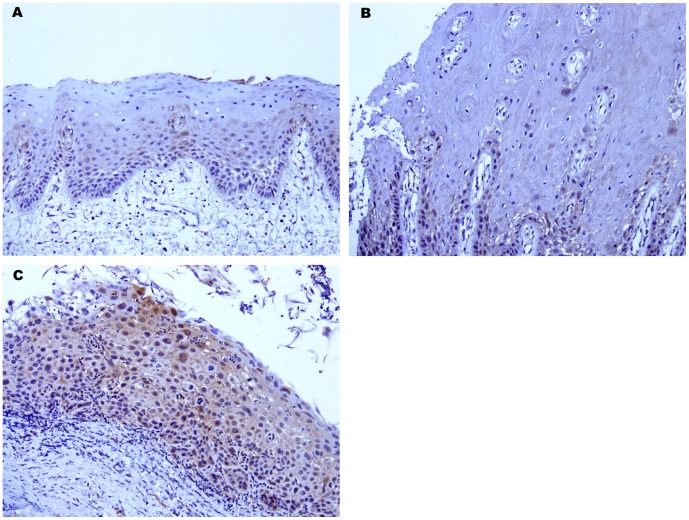
Representative IHC staining patterns for IL6 in normal oral epithelium (A) showing negative or barely conspicuous cytoplasmic staining (intensity = 0), hyperplastic oral epithelium (B) showing negative or barely conspicuous cytoplasmic staining (intensity = 0) and dysplastic oral epithelium (C) showing weak cytoplasmic staining (intensity = 1+).(Immunohistochemistry: original magnification×200).